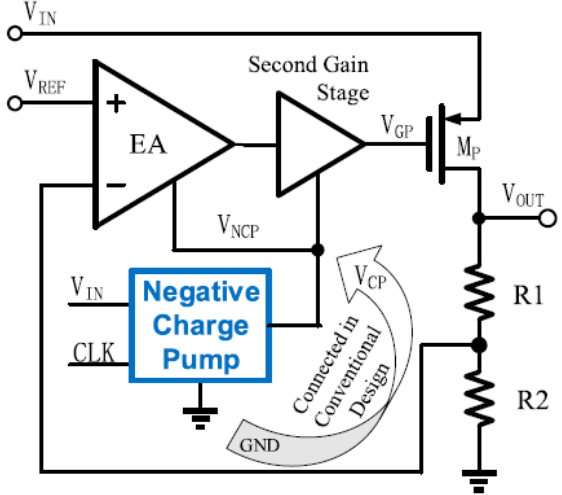
Figure 19. Negative Charge Pump-Enhanced ALDO